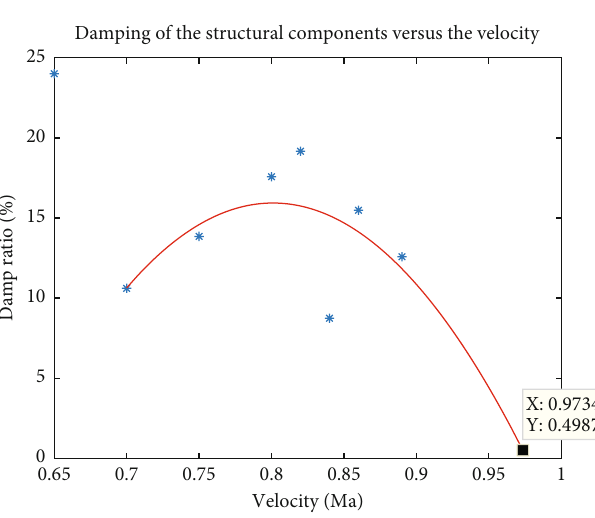
Figure 27: Damping ratio versus velocity diagram.